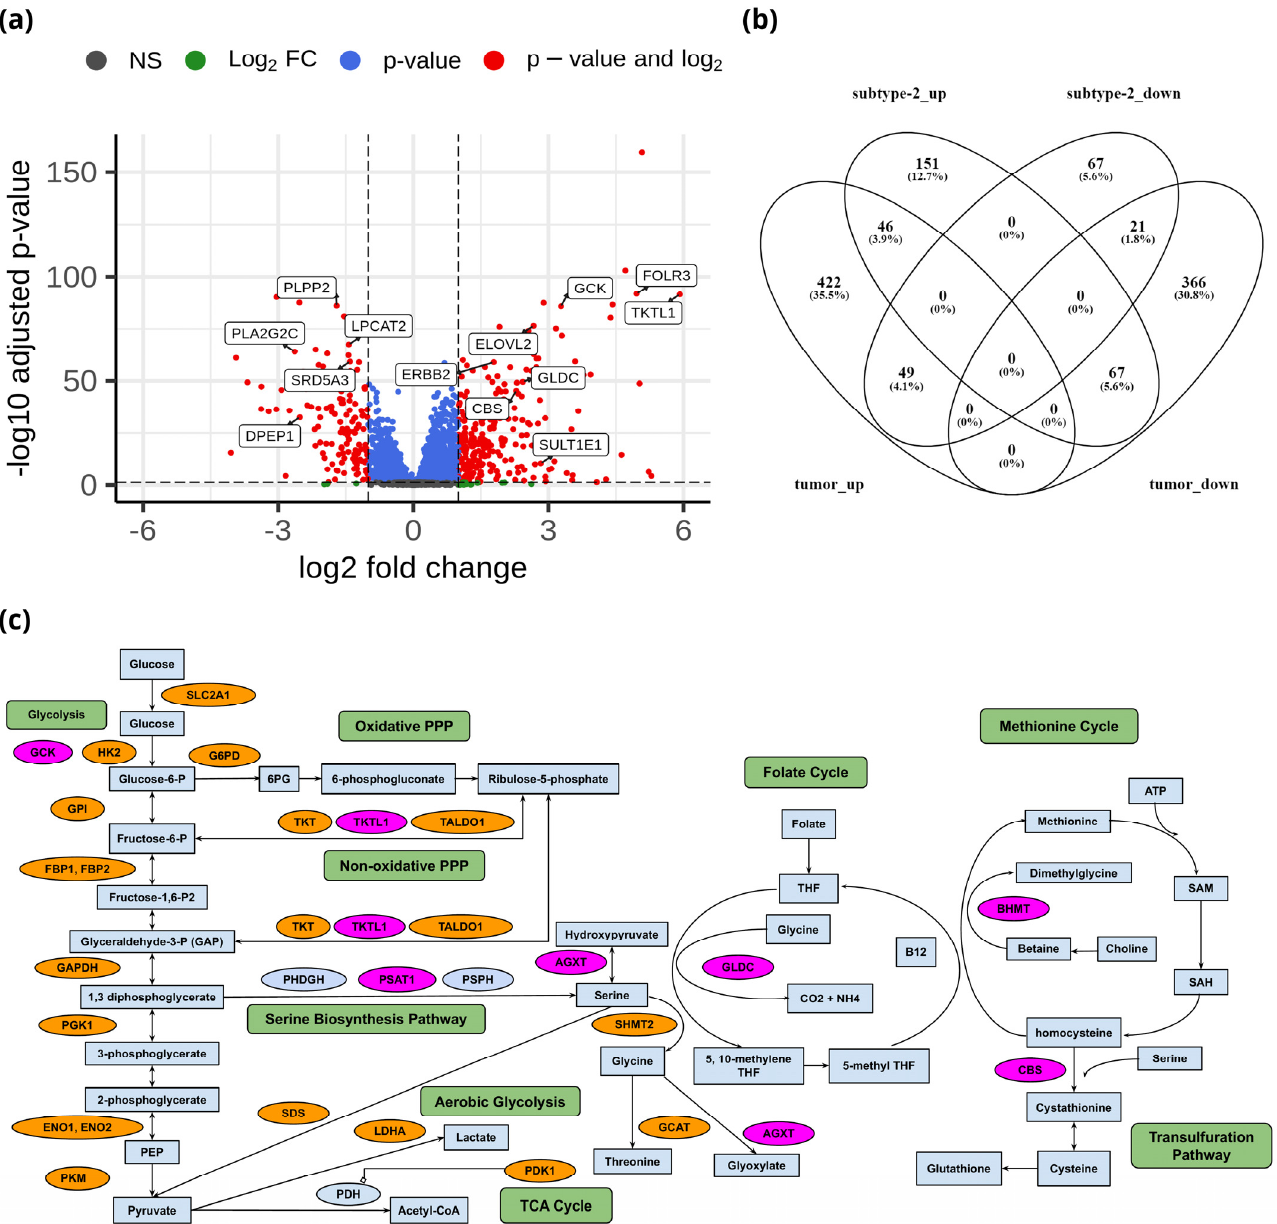
Figure 4. ( a ) Volcano plot showing DEGs between metabolic subtype-1 and subtype-2 samples. ( b ) Venn diagram showing the overlap of DEGs between metabolic subtype-1 vs. metabolic subtype-2 and normal vs. tumor comparisons (subtype-2_up: upregulated genes in metabolic subtype-2, subtype-2_down: downregulated genes in metabolic subtype-2, tumor_up: upregulated genes in the tumor, tumor_down: downregulated genes in the tumor). Venny 2.1 was used to generate the Venn diagrams. ( c ) Metabolic pathways altered in EC and metabolic subtype-2 samples. Orange and pink colors represent upregulated genes in normal vs. tumor conditions and metabolic subtype-1 vs. metabolic subtype-2 conditions,